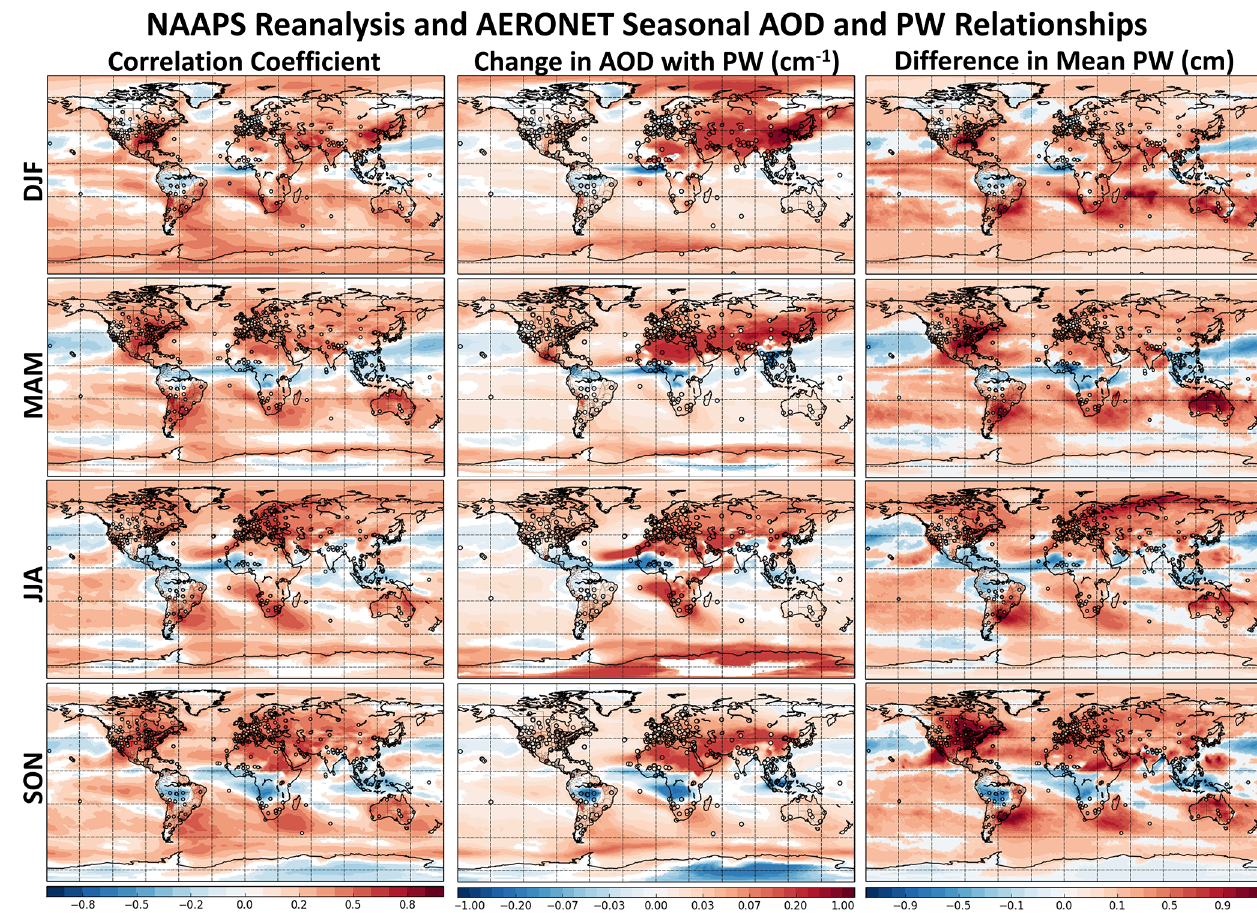
Figure 7. Seasonal AOD and PW relationships based on AERONET data (circles) and the NAAPS-RA (global map) shown as (1) correlation coefficients between daily-averaged AOD and PW (non-zero values are statistically significant at the 95% level), (2) Theil–Sen regression slopes (change in AOD with PW) between daily-averaged AOD and PW (in cm − 1 ) at locations where the correlation is statistically signif- icant, and (3) the statistically significant difference in mean PW (cm) between the PW distribution associated with high-AOD events ( > 1 standard deviation above mean) and the PW distribution for all AOD values. Red regions indicate a positive relationship between AOD and PW (higher moisture conditions for higher AOD events), and blue regions indicate a negative relationship (drier conditions for higher AOD